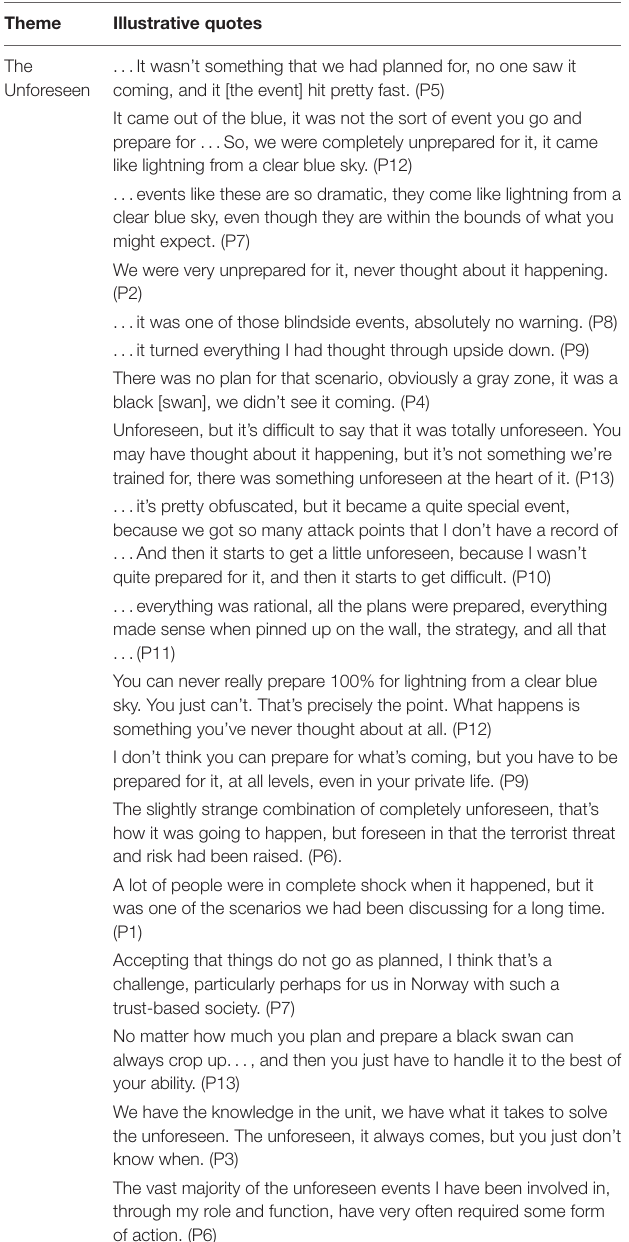
TABLE 3 | Quotes from experts illustrating experience with the unforeseen as a phenomenon. Theme Illustrative